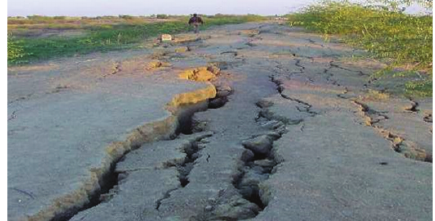
Figure 10: Cracking and inelastic deformations of the crest in an embankment dam caused by the 2001 Buhl earthquake in India.